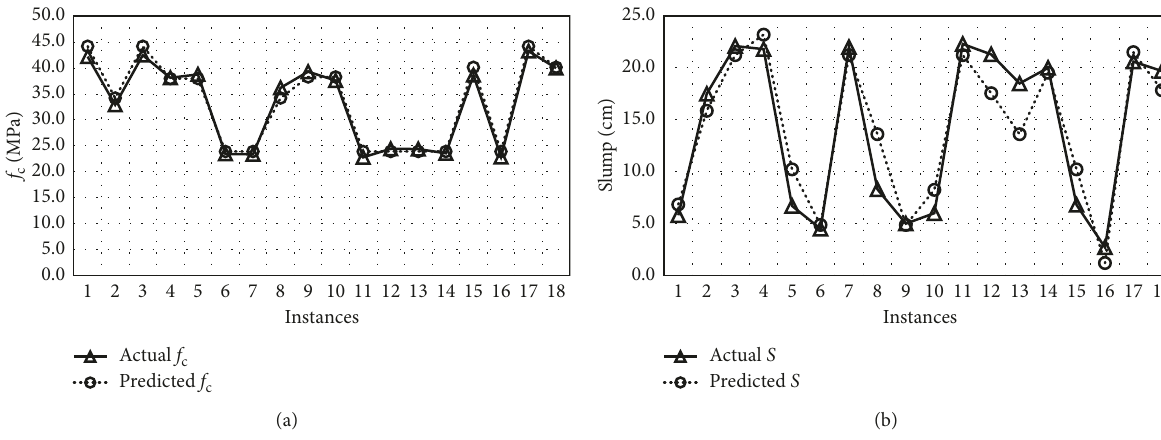
Figure 4: Comparison between actual and predicted values of f